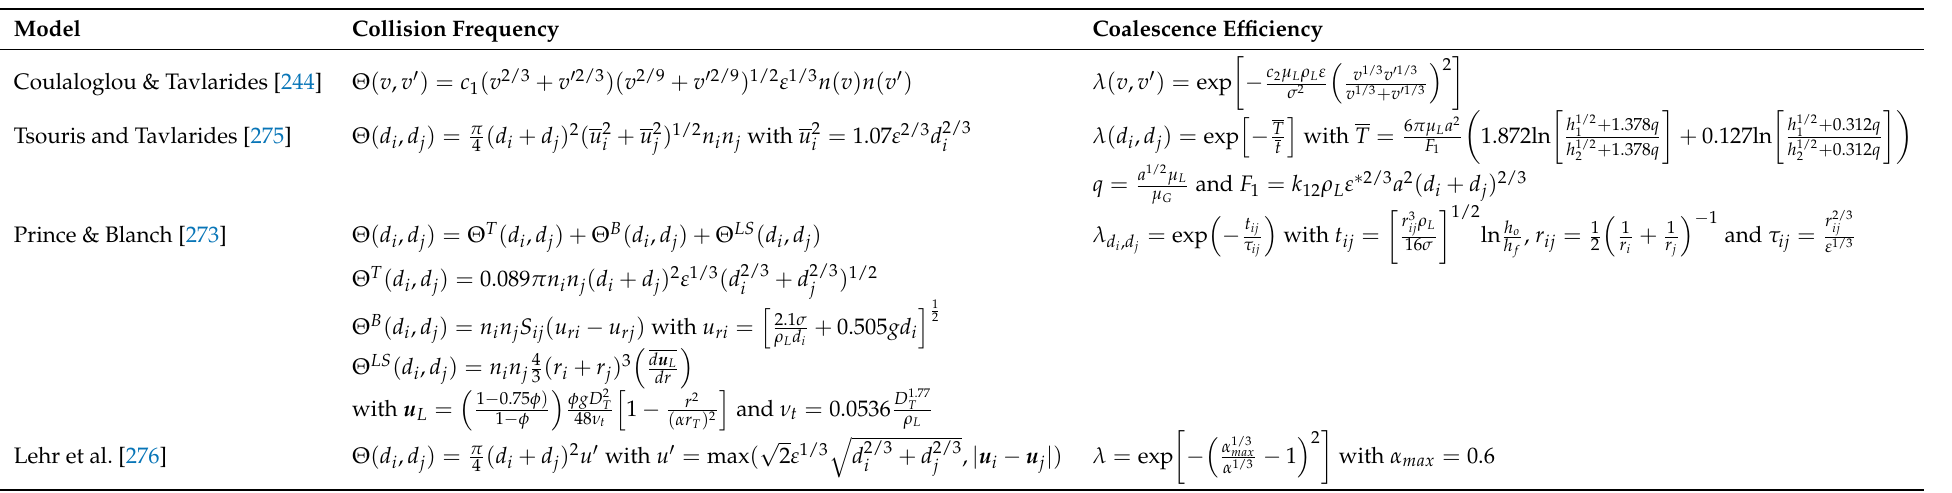
Table 12. Overview on selected coalescence models for population balance